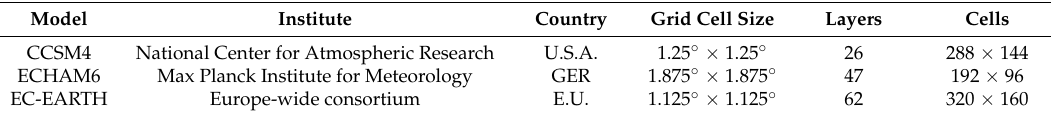
Table 2. Features of the three adopted